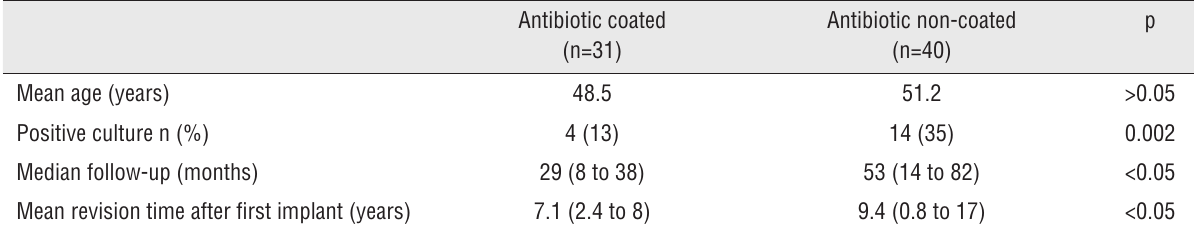
Table 1 - comparison of characteristics of both